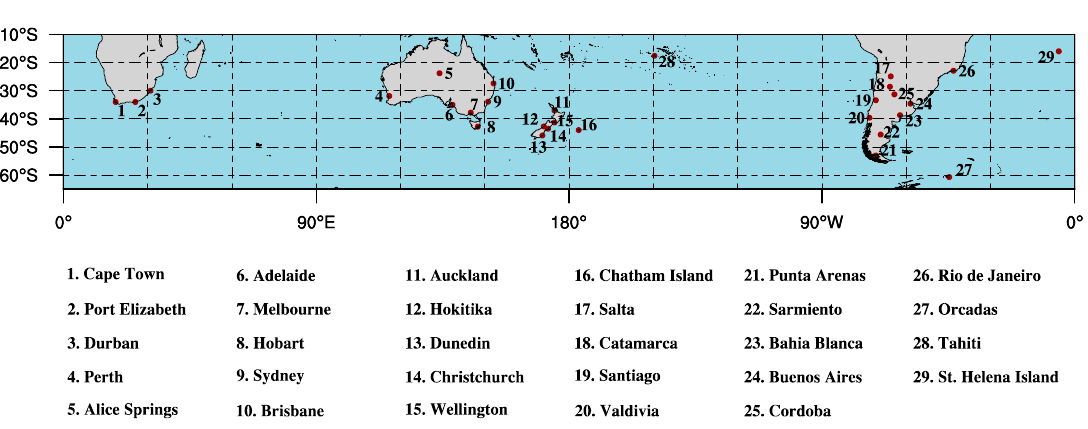
Figure 1. Map and list of names of the 29 midlatitude stations used in the study as the grid point locations in CAM5 for performing the PCR reconstruction method.